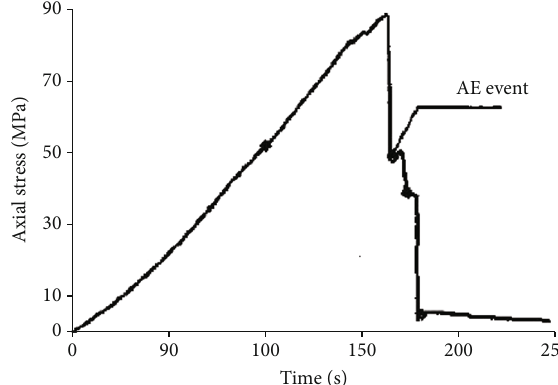
Figure 3: The variation of AE events with stress-strain.